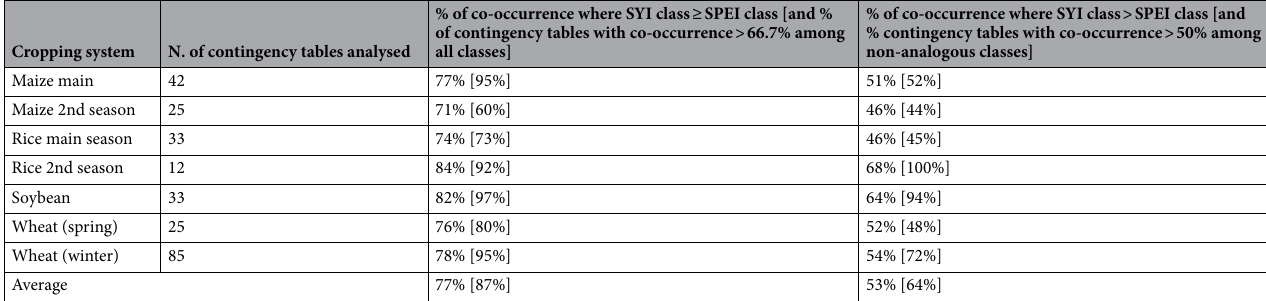
Table 1. Aggregated results, per cropping system, in terms of average dominance—across contingency tables analysed (second column)—in the co-occurrence of SYI magnitude classes equal or severer (third column), or only severer (fourth column), than SPEI classes within the lower-than-normal both moisture and yield macro- class ( LY_D ). Enter brackets, the share of duration-timing contingency tables presenting above threshold dominance is reported as calculated over the total number of contingency tables